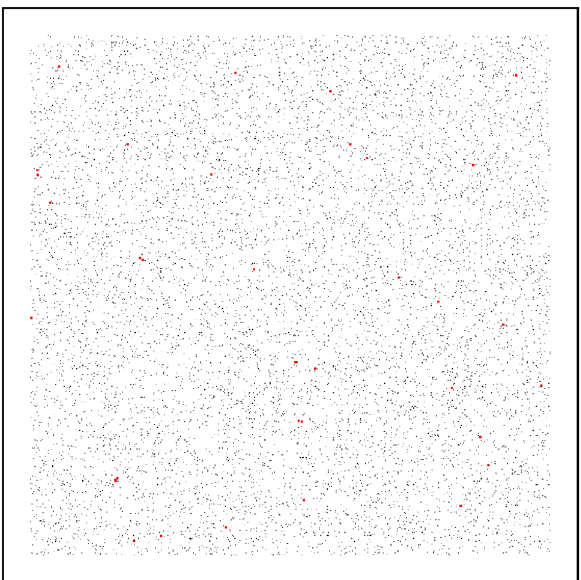
Figure 15. This graph represents the initial state of the pandemic. The black dots denote the position of the susceptible population. The red dots denote the position of the infectious population. The virtual environment contains 10,000 population, in which, 70 (0.7%) of them are infectious. This is a challenging scenario because the infectious is heavily spread all over the regions. The density of the environment is set to be 0.02.